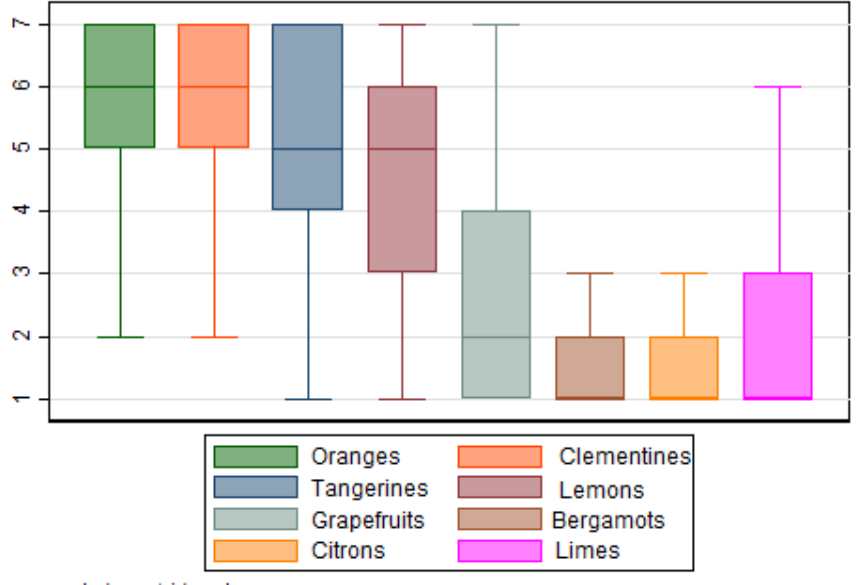
Figure 1. Citrus fruits’ preference scores. Scale from 1 = disliked totally, to 7 = extremely liked. Nutrients 2020 , 12 , x FOR PEER REVIEW